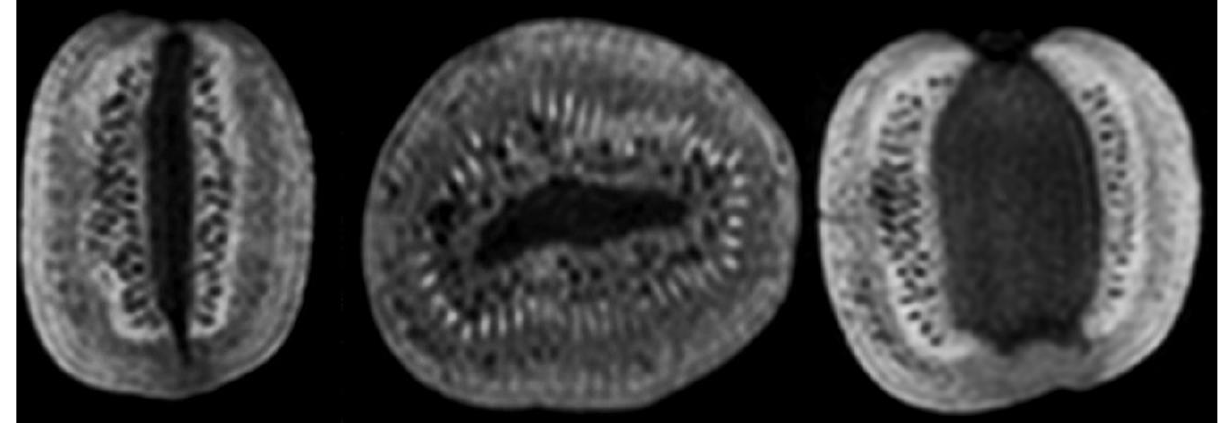
Figure 1. Representative orthogonal 3T MR images of a kiwi: 3D T1 weighted sagittal, coronal, and axial high resolution (1 × 1 × 1 mm 3 ).